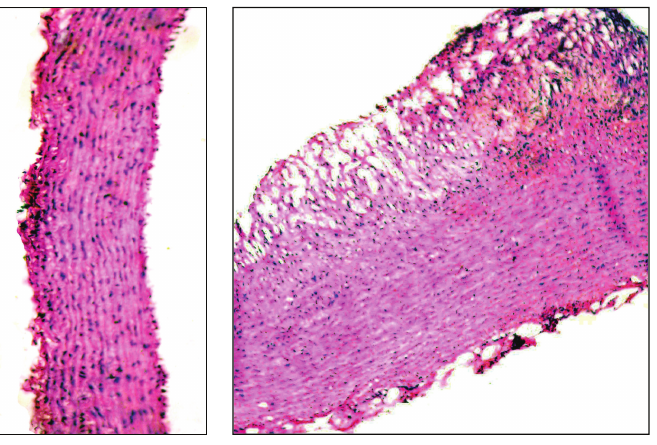
Table 3: Effects of Acacia senegal seed extract (AS, 500mg/kg/day, p.o.) or statin (0.25 mg/kg/day, p.o.) treatment for 45 days on the alteration in liver, heart, kidney, and aorta weight, all in gm/Kg body weight in hypercholesterolemic (Chol) diet fed atherosclerotic male rabbits. Groups Liver Heart Kidney Aorta Control 26.34 ± 1.35 Chol Chol + AS Chol + statin 25.76 ± 1.32 d,g 2.57 ± 0.14 d,h 6.67 ± 0.32 d,h 0.27 ± 0.12 c,g Data are means ± S.E.M. ( 𝑛 = 8); c 𝑃 ≤ 0.001; d nonsignificant as compared to the respective control values; g 𝑃 ≤ 0.001; and h nonsignificant as compared to the respective values of the Chol diet fed group.